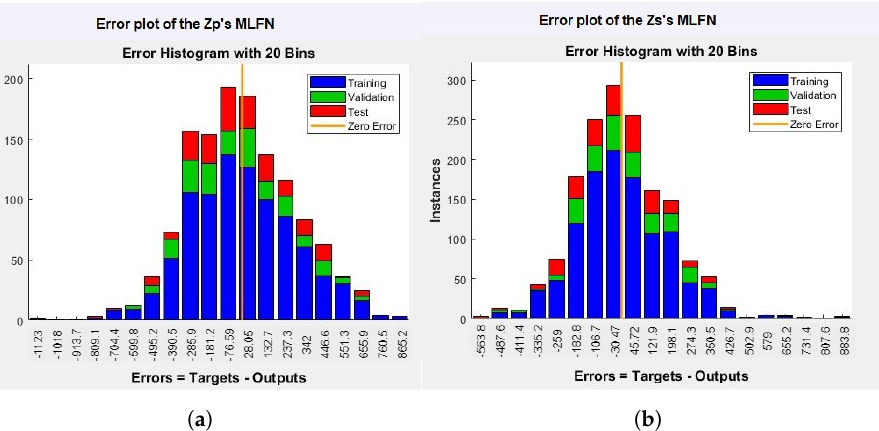
Figure 15. The error histograms of the ( a ) Z P and ( b ) Z S MLFN models, where the error value is on the X-axis and the error frequency (instances) is on the Y-axis. The errors of the training, validation, and testing data appear in blue, green, and red colors,